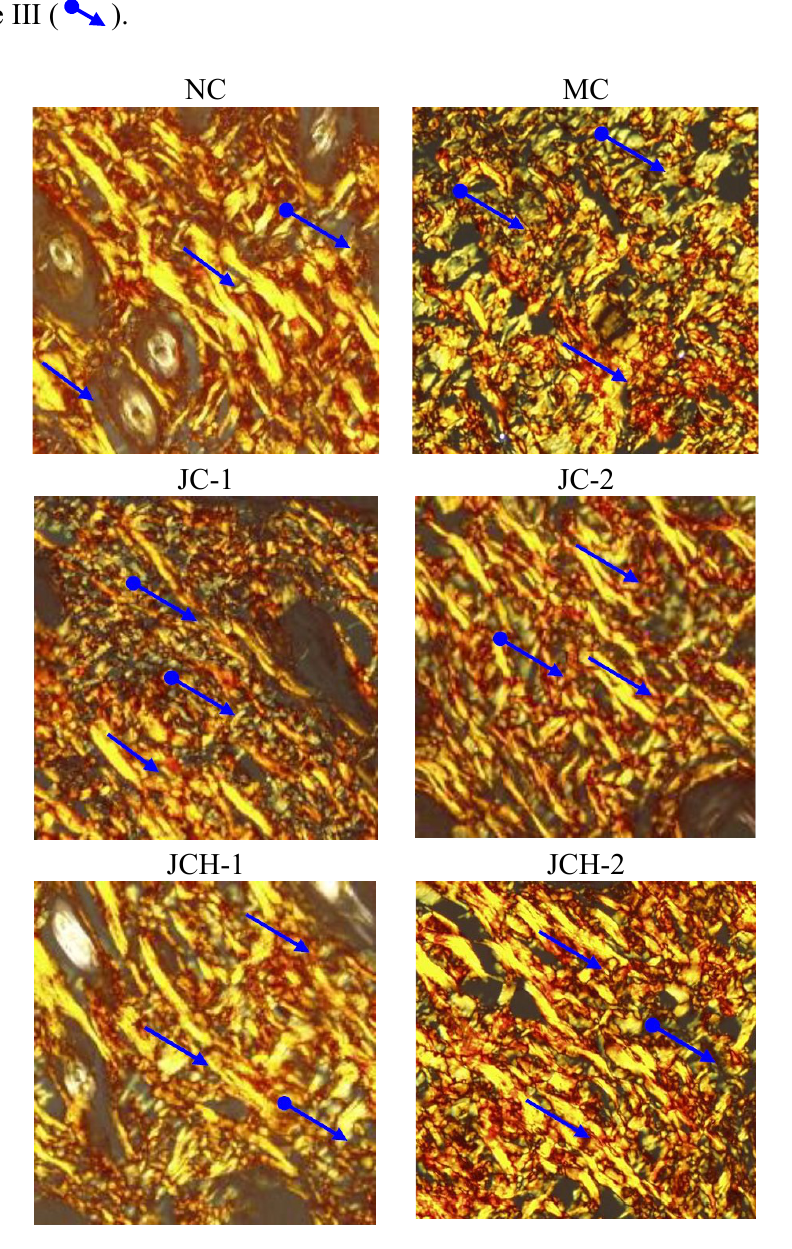
Figure 3. The effect of JC and JCH on collagen type I and collagen type III of photoaging skin (magnification 200×); Yellow-orange: collagen type I ( ),